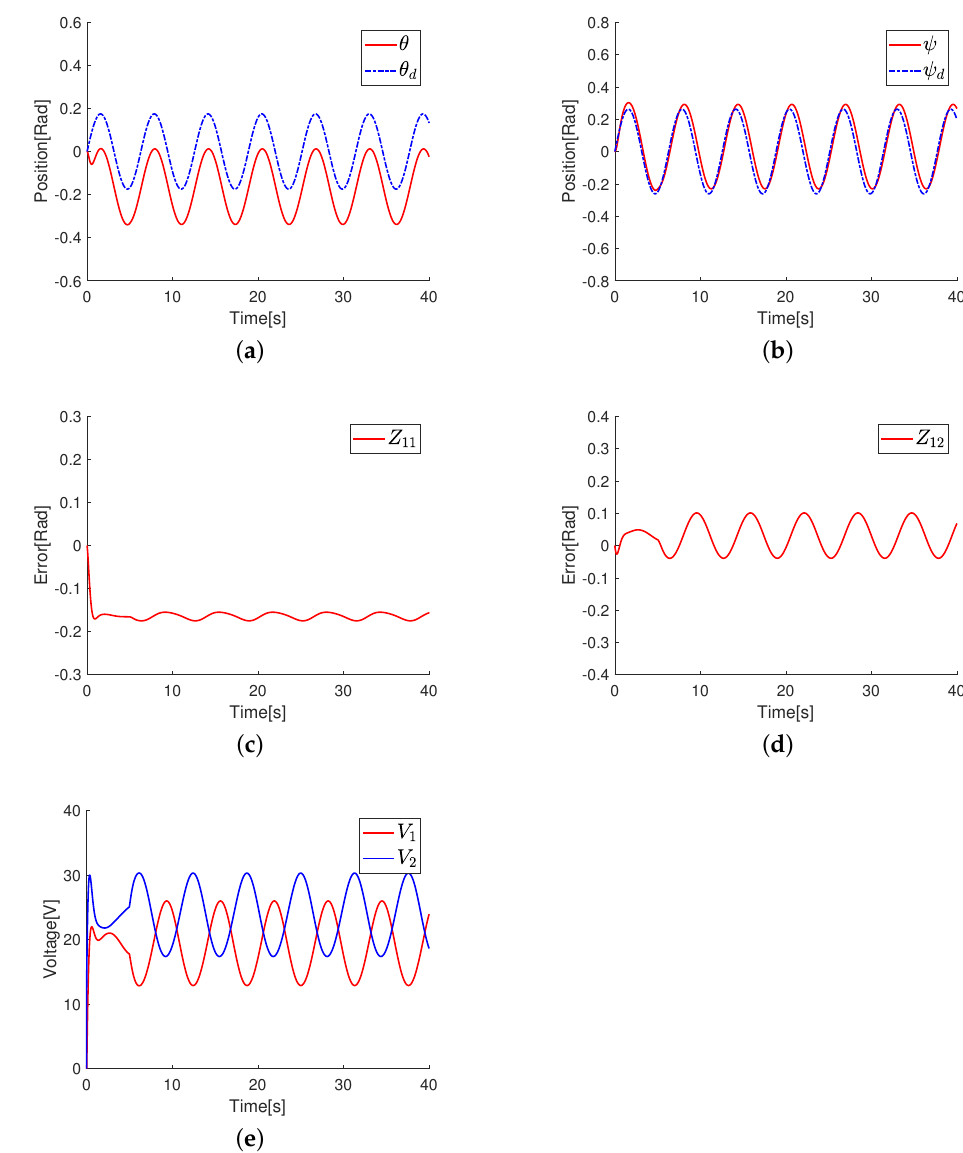
Figure 2. The control performance under the LQR control. ( a ) Tracking trajectory diagram of θ . ( b ) Tracking trajectory diagram of ψ . ( c ) Tracking error diagram of θ . ( d ) Tracking error diagram of ψ . ( e ) The input signals of the 2-DOF helicopter